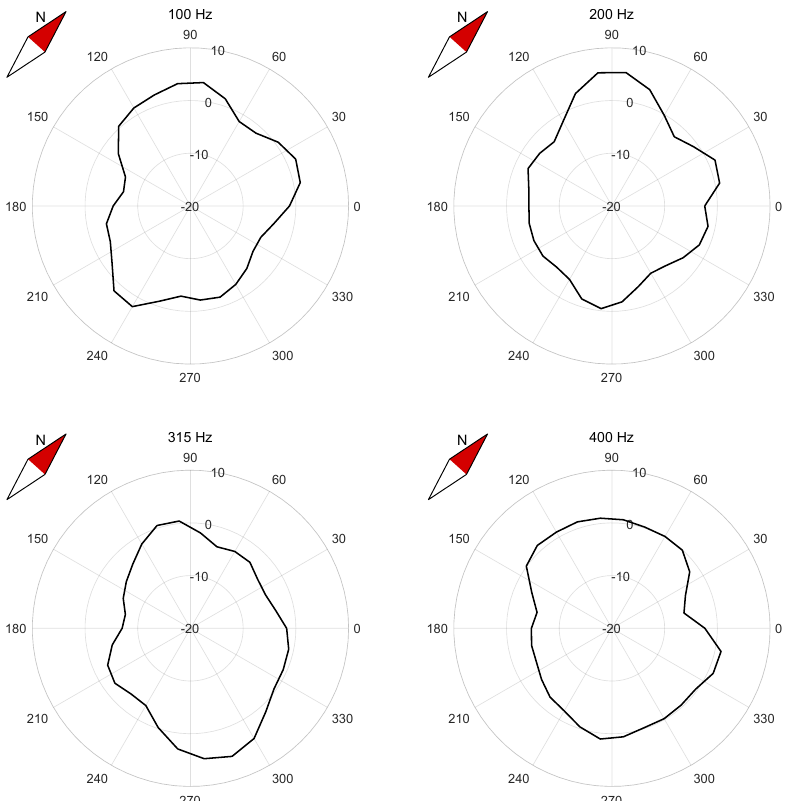
Figure 6. Directivity plots for the three frequencies under investigation (averaged over three heights: 1.5 m, 2 m and 3.1 m).